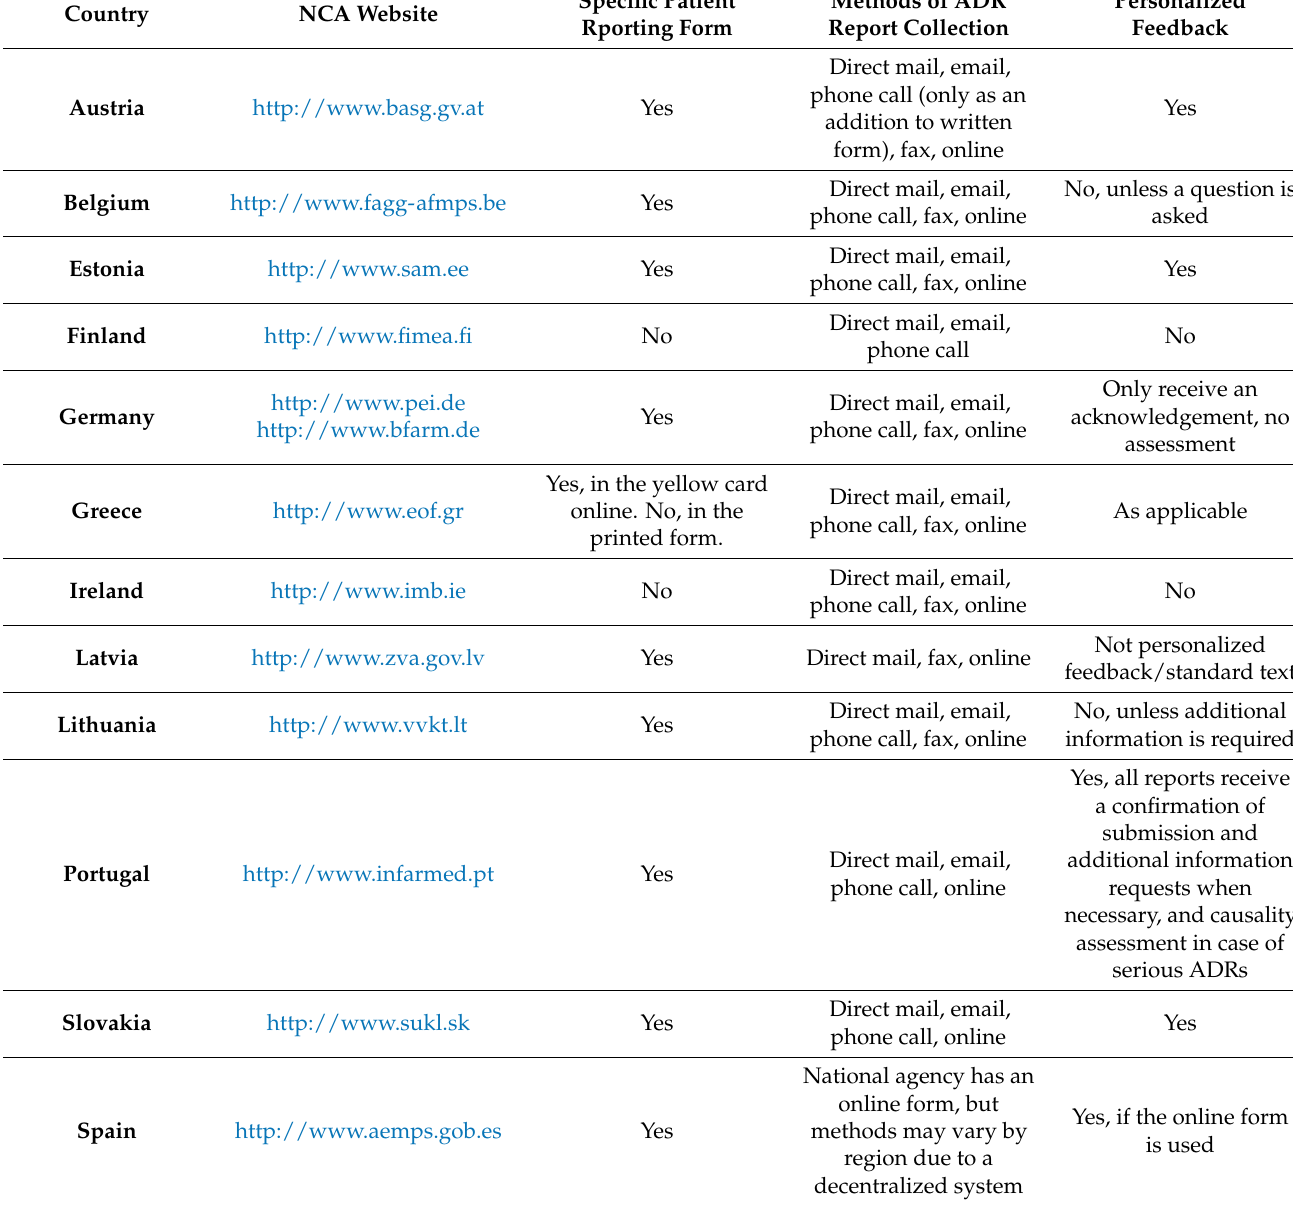
Abbreviations: ADR, adverse drug